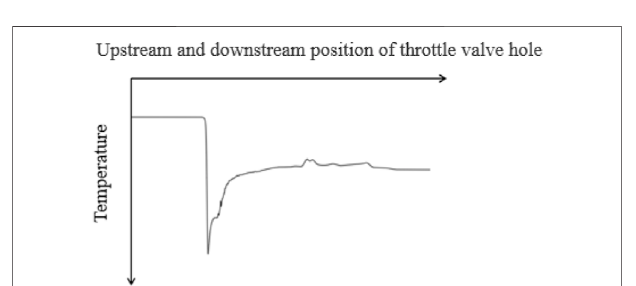
FIGURE 6 | Temperature trend curve of the throttling valve hole.